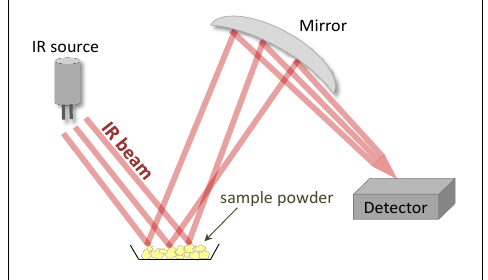
Figure 6. Diffuse reflectance (DRIFTS) mode, where an IR beam is focused on the powdered samples and the scattered light is collected by a parabolic mirror.